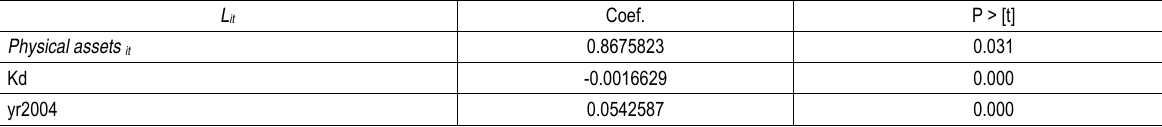
Table 8 shows the results. Table 8. Regression results, Model